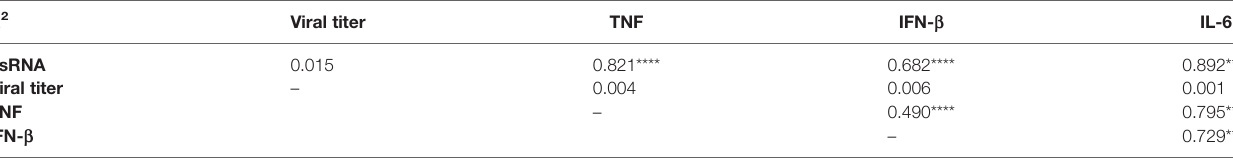
TABLE 1 | Correlation analysis between dsRNA positive hMDM, infectious virus titers and pro-in fl ammatory cytokines. R